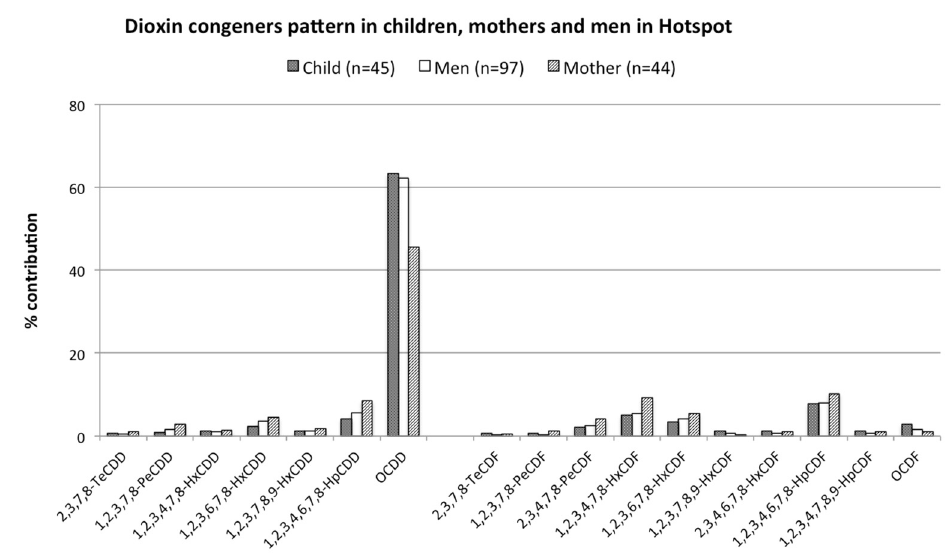
Figure 2. Congener patterns for PCDD/Fs in children, mothers, and men living in the hotspot area.